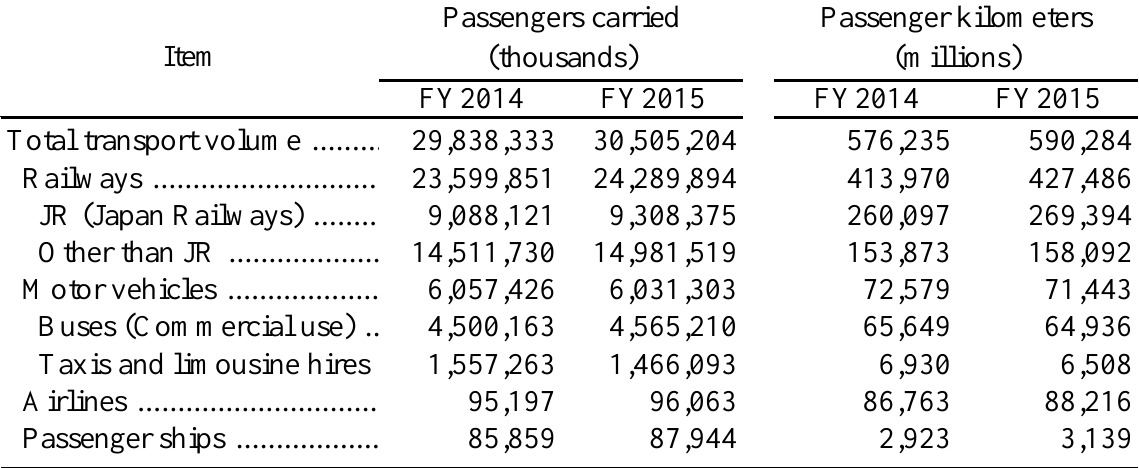
Buses (Commercial use) .. Taxis and limousine